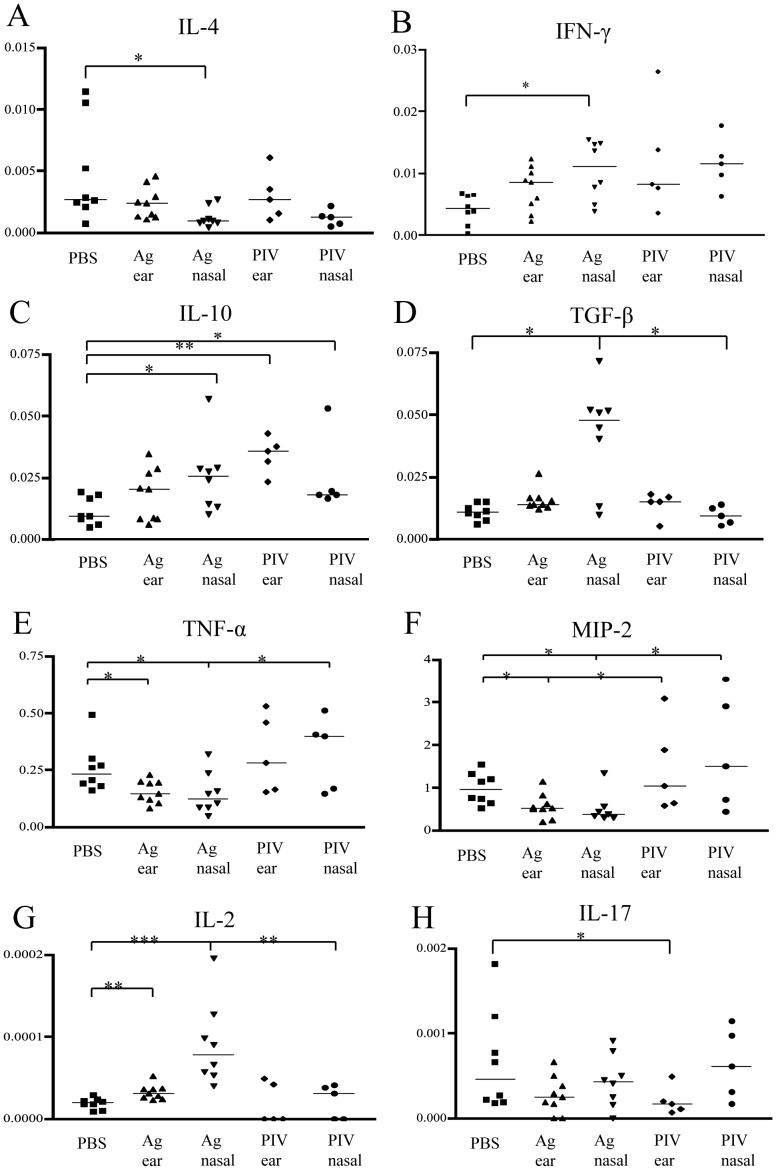
Changes in cytokines mRNA expression levels in the ears of AD mice by vaccination of rhPIV2/Ag85B.Cytokines: IL-4 (panel A), IFN-γ (panel B), IL-10 (panel C), TGF-β (panel D), TNF-α (panel E), MIP2-α (panel F), IL-2 (panel G), IL-17 (panel H), mRNA expression in the ear lesions measured with Quantitative RT-PCR. Expressions of IL-4, TNF-α and MIP2-α mRNA were significantly decreased in the ear skin treated with intra-nasally rhPIV2/Ag85B treated group compared to those of control groups. Meanwhile, the expression levels of mRNA of IFN-γ, IL-10, TGF-β and IL-2 were significantly elevated in rhPIV2/Ag85B intra-nasally treated group compared to those of control groups. *P<0.05, **P<0.01, ***P<0.001.